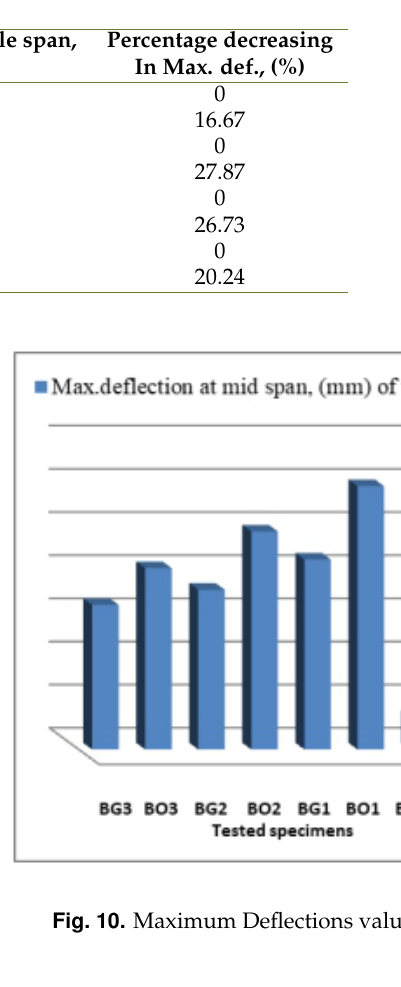
Table 6. Maximum Deflection Values of Tested Beams